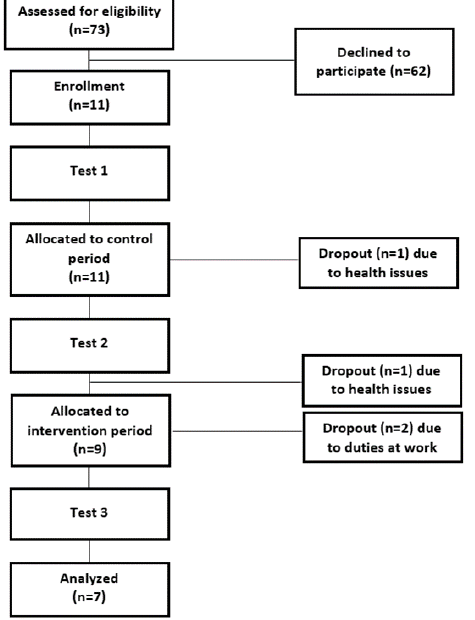
Figure 1. Flowchart of the protocol steps .